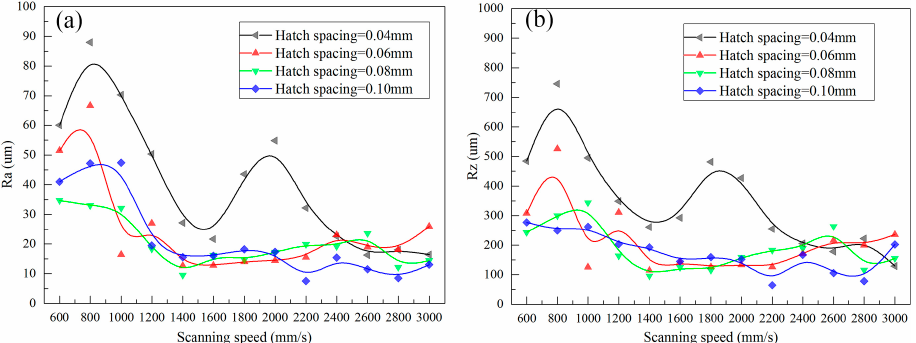
Figure 10. (cid:1844) (cid:3028) ( a ) and (cid:1844) (cid:3053) ( b ) of lower surface. Figure 10. R a ( a ) and R z ( b ) of lower